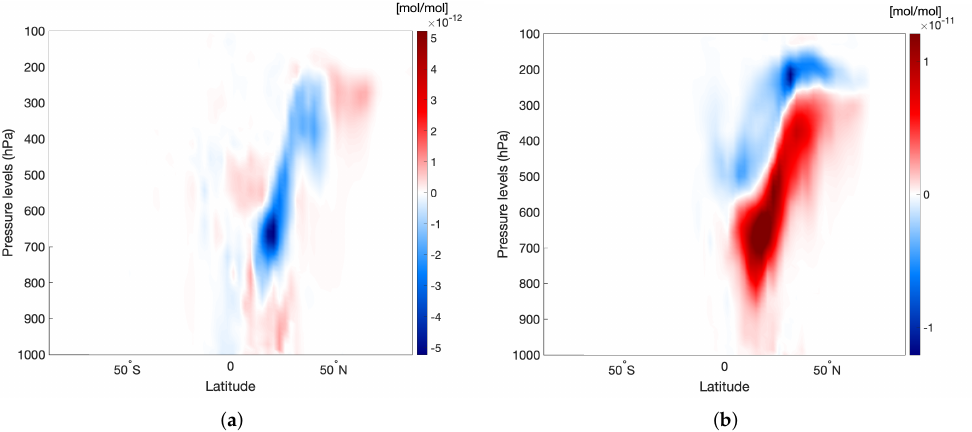
Figure 14. Difference of the zonal mean O 3 atf mixing ratio (mol/mol) between climate-optimised flights and cost-optimised flights on 8 February 2016, a week after the release of the emissions for ( a ) lateral re-routing and ( b ) vertical